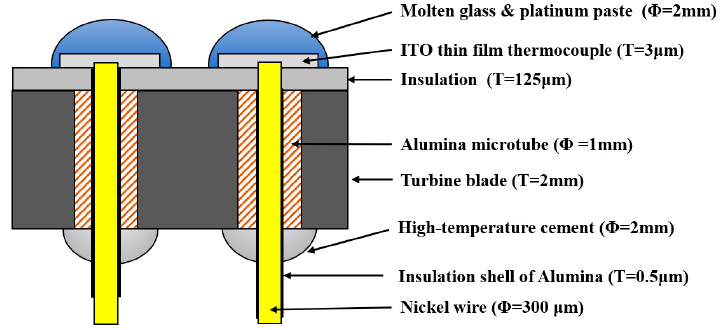
Figure 4. Lead connection diagram.